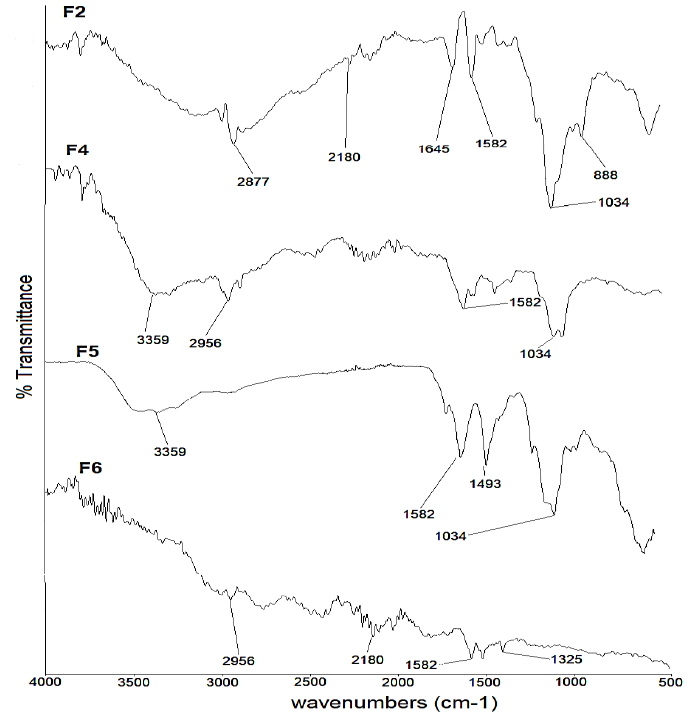
Figure 4. FTIR spectra of F2, F4, F5 and F6 formulations.